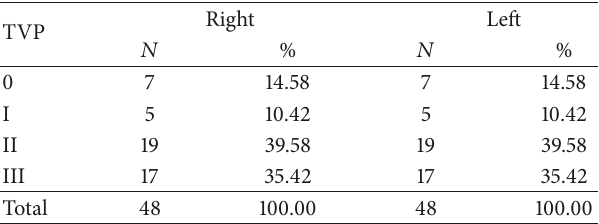
Table 2: Distribution of TVP categories in the right and left thyroid lobes.